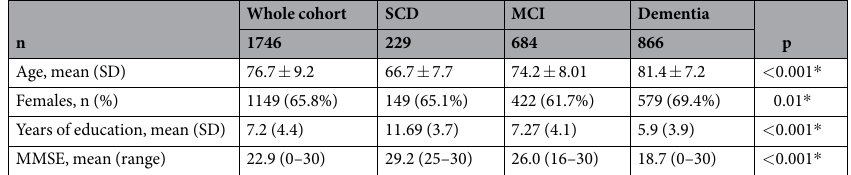
Table 1. Demographic characteristics of the study cohort. Statistical significance was set up at p < 0.05. A Chi-Square test was used to compare gender differences among groups. 1-factor ANOVA was used to compare age, years of education and MMSE scores differences among groups. MCI = mild cognitive impairment; MMSE = Mini-Mental State Examination; OCT = optical coherence tomography; SCD = subjective cognitive decline; SD = standard deviation.